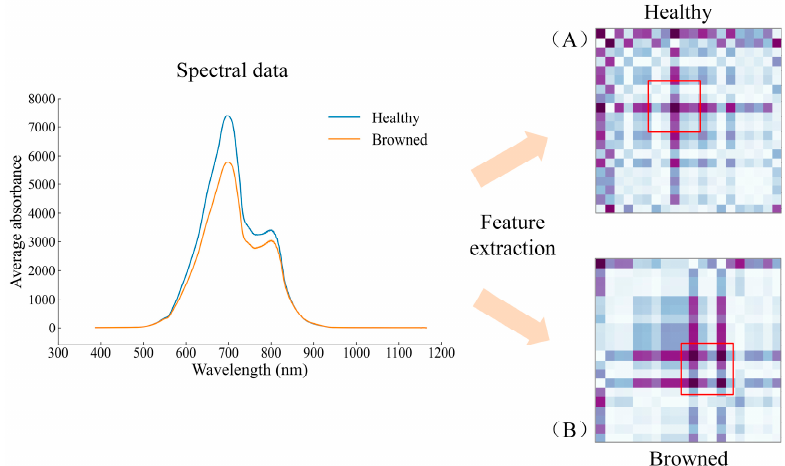
Figure 9. GAF coding process of spectral data of Yali pears.